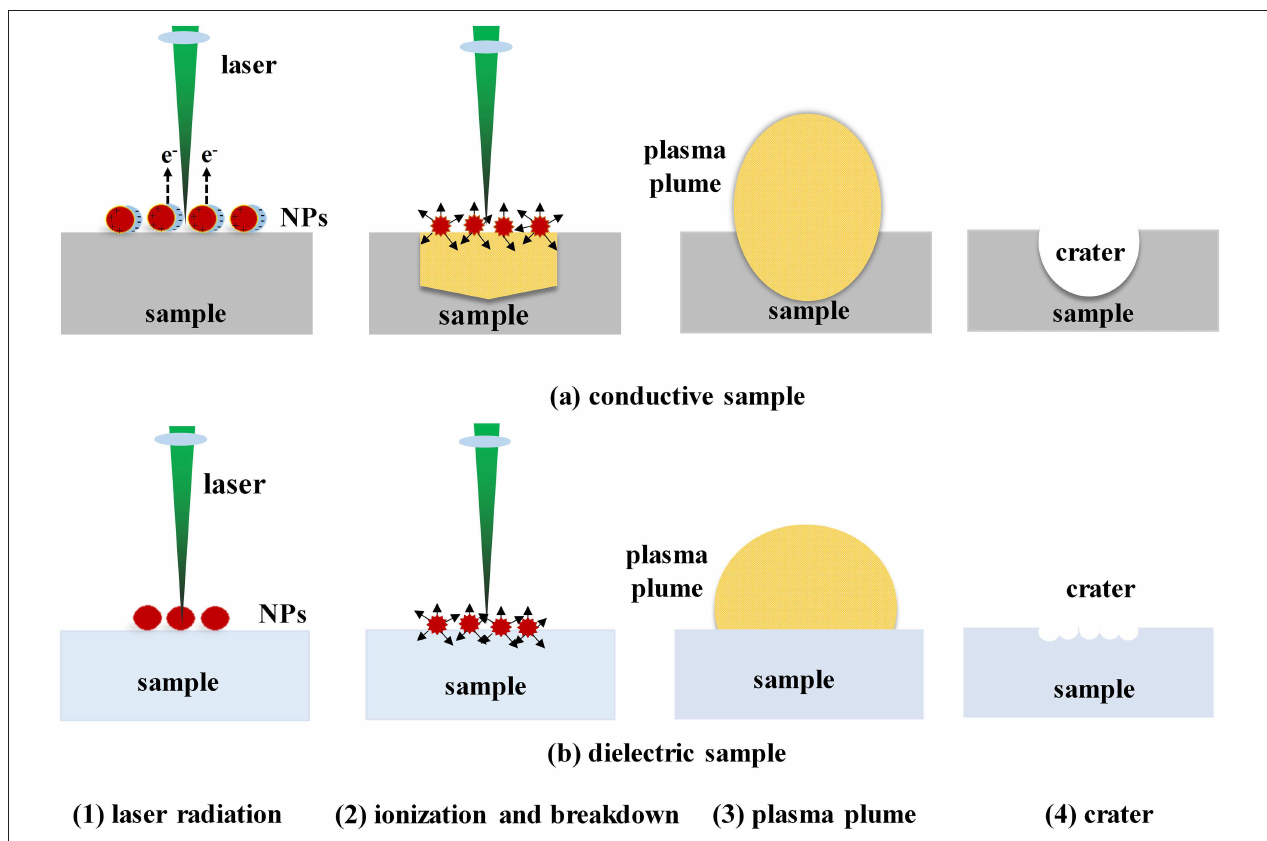
FIGURE 4 | The Schematic diagram of nanoparticles acting on (a) conductive sample and (b) dielectric sample: (1) laser radiation; (2) ionization and breakdown; (3) plasma generation; (4) crater.